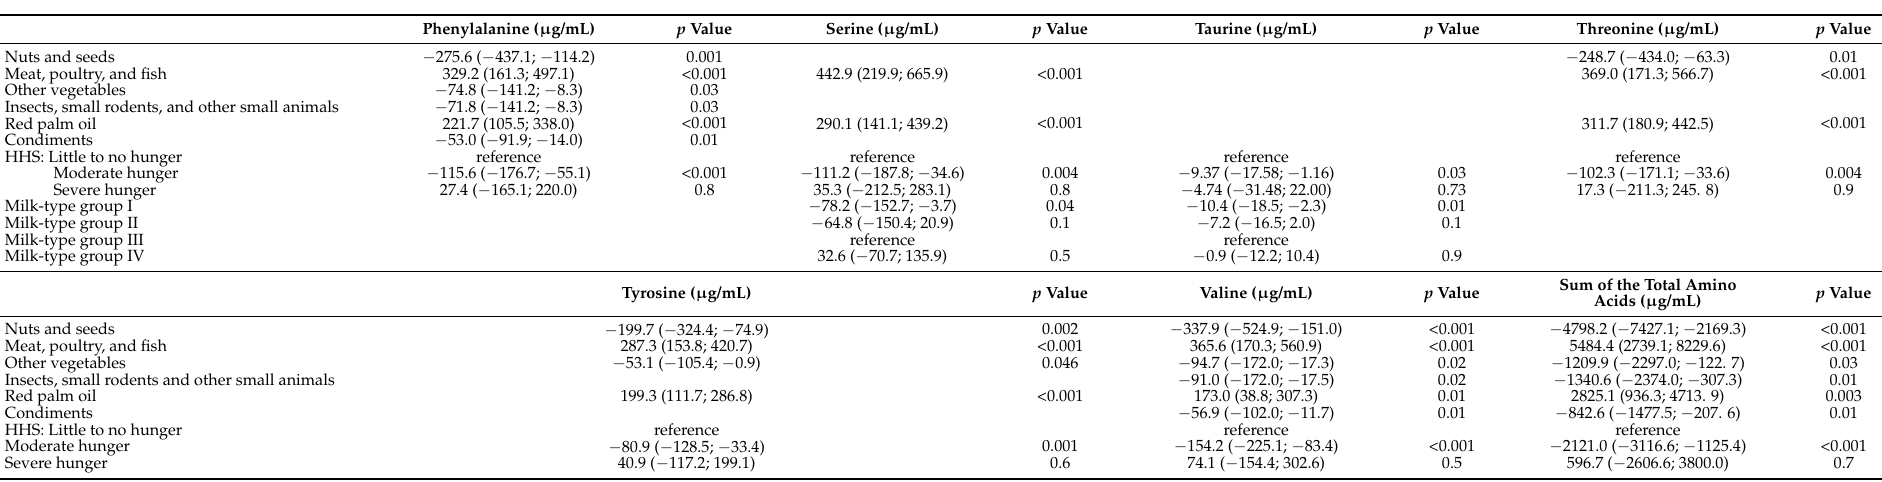
Table 8. Multilevel models of the dietary determinants of human milk total amino acids during the first 6 months of life